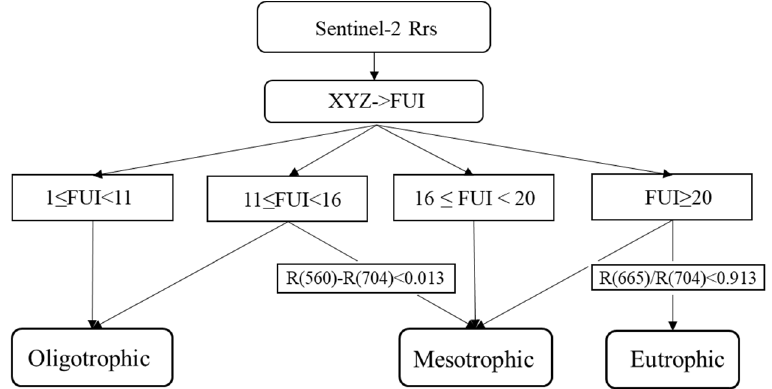
Figure 9. FUI-based water eutrophication assessment decision tree.